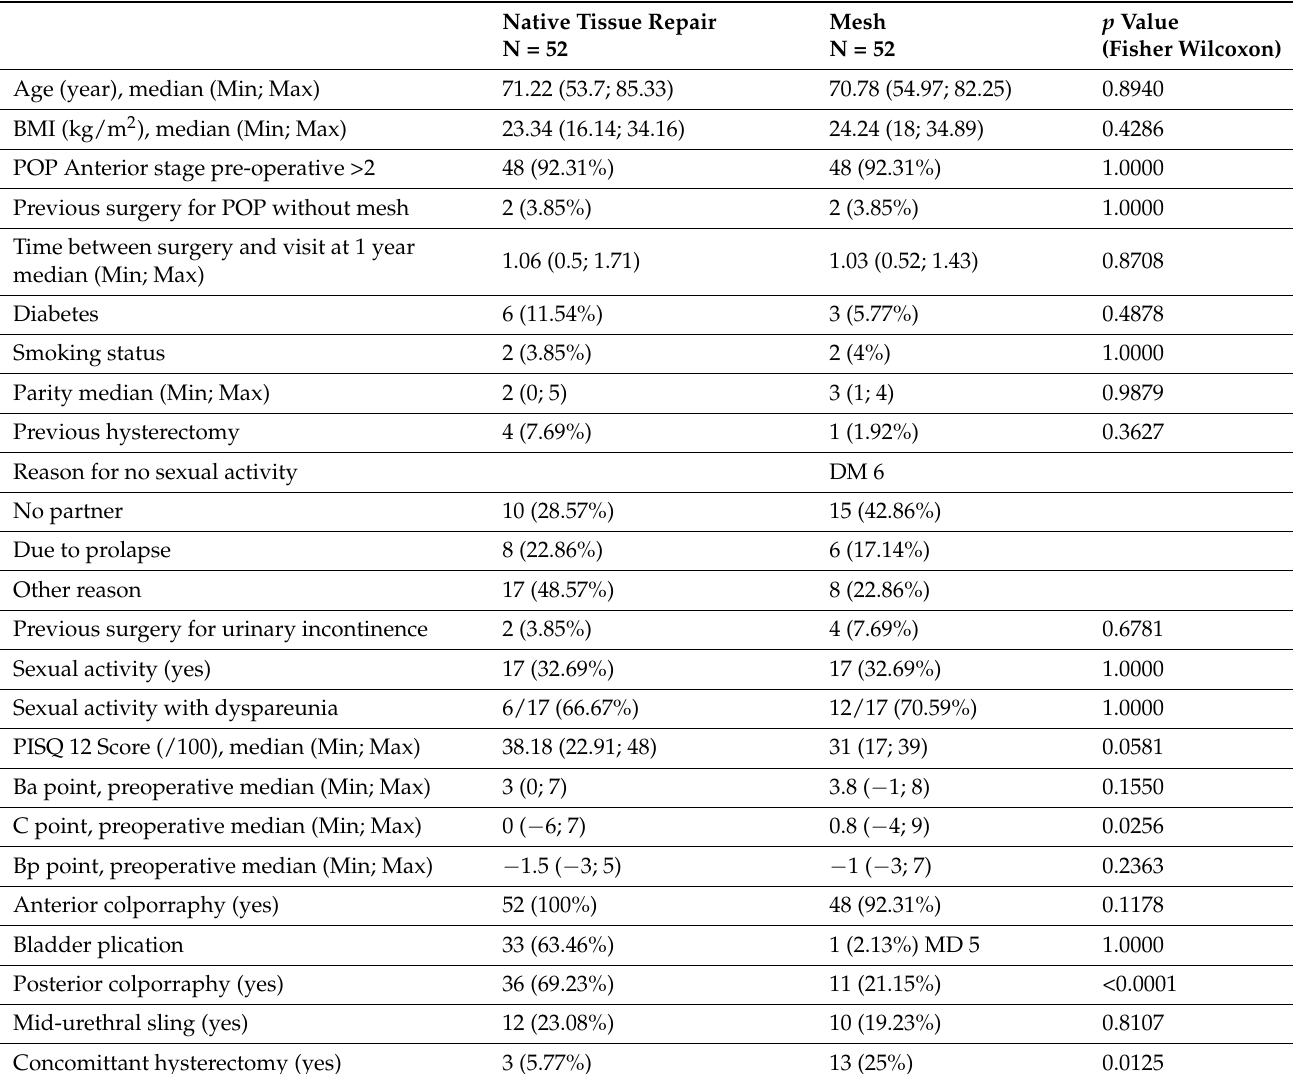
Table 1. Participant characteristics (N =